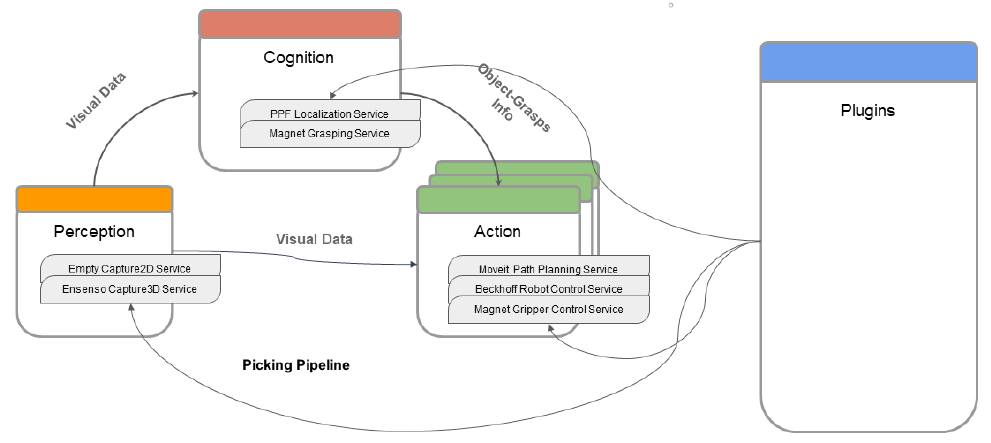
Figure 2. Select plugin/services for a picking pipeline.